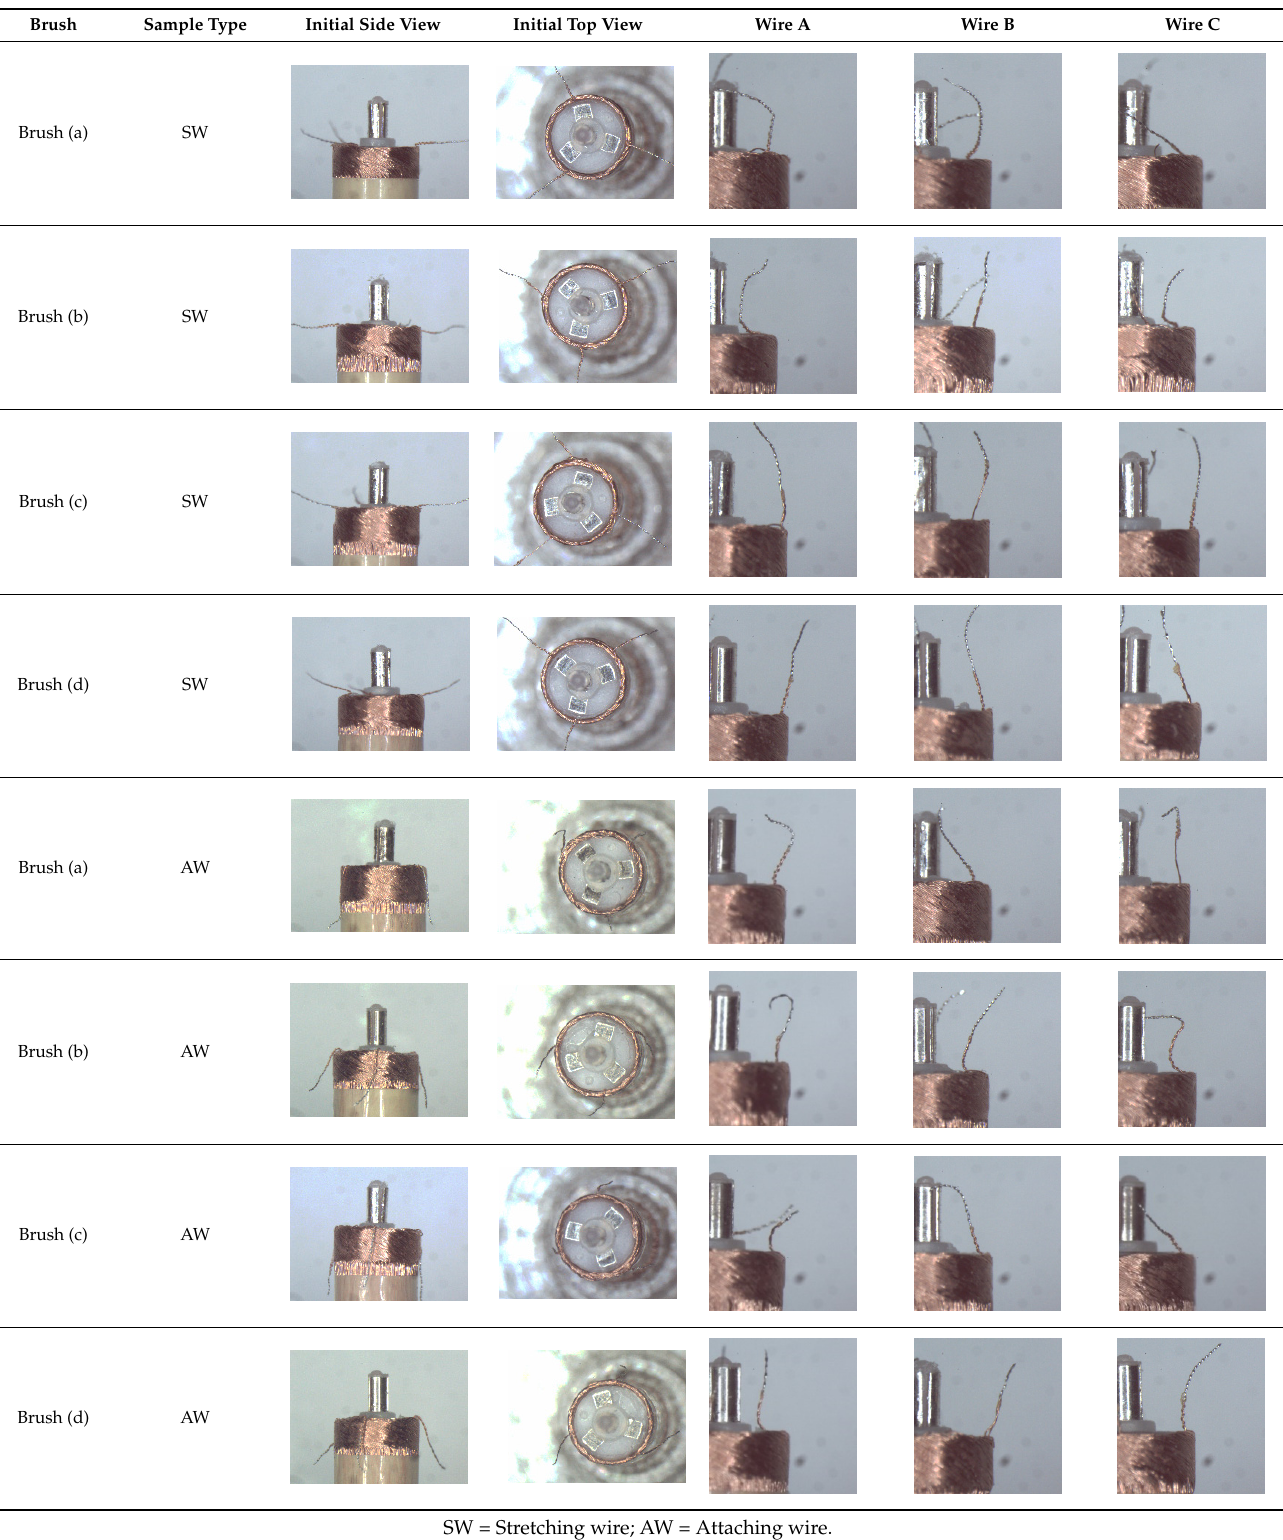
Table 9. Brushing results for two types of samples using the micro-manipulators shown in Figure 10.